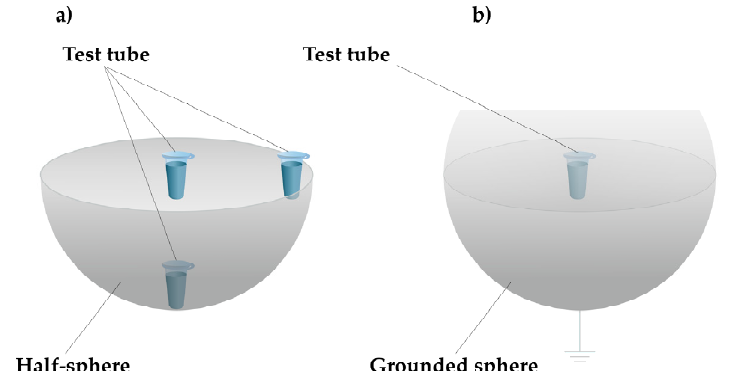
Figure 1. Experimental setup. The test tube containing a 0.1 µ M (10 − 7 M) solution of HRP in a 2 mM PBSD buffer was incubated within an ungrounded metallic half-sphere (in its center, near its edge, or at its bottom) ( a ), in the center of a grounded metallic sphere ( b ), or 2 m away from the experimental setup (control experiment).